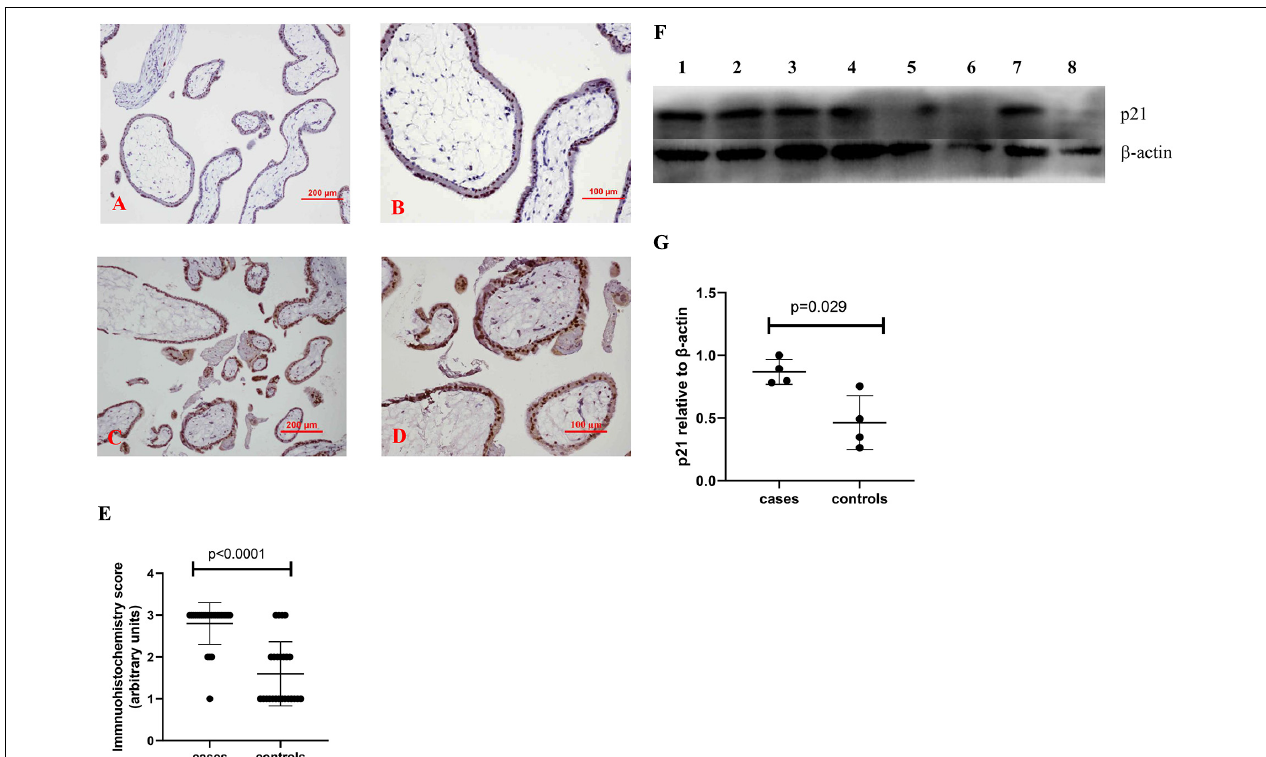
FIGURE 2 | Representative immunohistochemical staining showing that the levels of p21 were increased in missed miscarriage placentas [ (C) low magnification, D: high magnification] compared to healthy first-trimester placentas [ (A) low magnification, B: high magnification]. Semiquantitative analysis of the immunohistochemistry images showing a significantly increased expression of p21 in placentas from missed miscarriage (E) . Representative Western blot (F) demonstrating that the levels of p21 were significantly increased in missed miscarriage placentas (lanes 1–4) compared to controls (lanes 5–8), measured by a semiquantitative analysis (G)